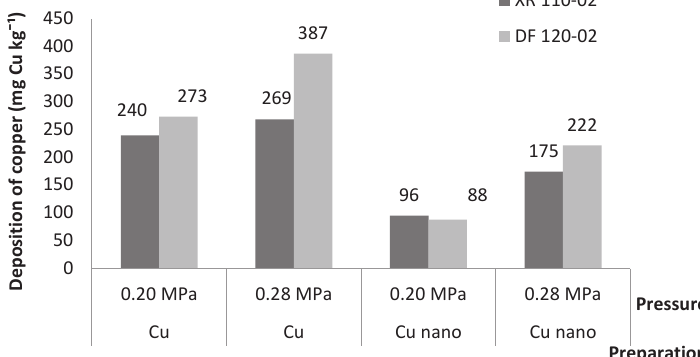
Fig.1. The deposit of copper to rape plants at the development phase of 2 leaves (12 BBCH) for the studied nozzles (flat fan XR 110-02 and double flat fan DF 120-02) at the pressure of 0.20 and 0.28 MPa. Cu –fertilizer was Mikrovit Copper 80 and Cu nano – contained nano copper.